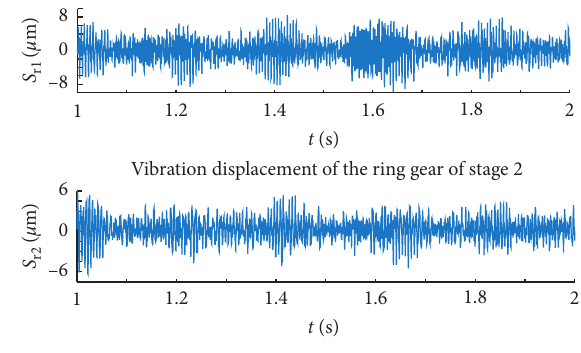
Figure 13: Vibration displacement of ring gears. Table 3: Vibration peak-to-peak values of the ring gear.